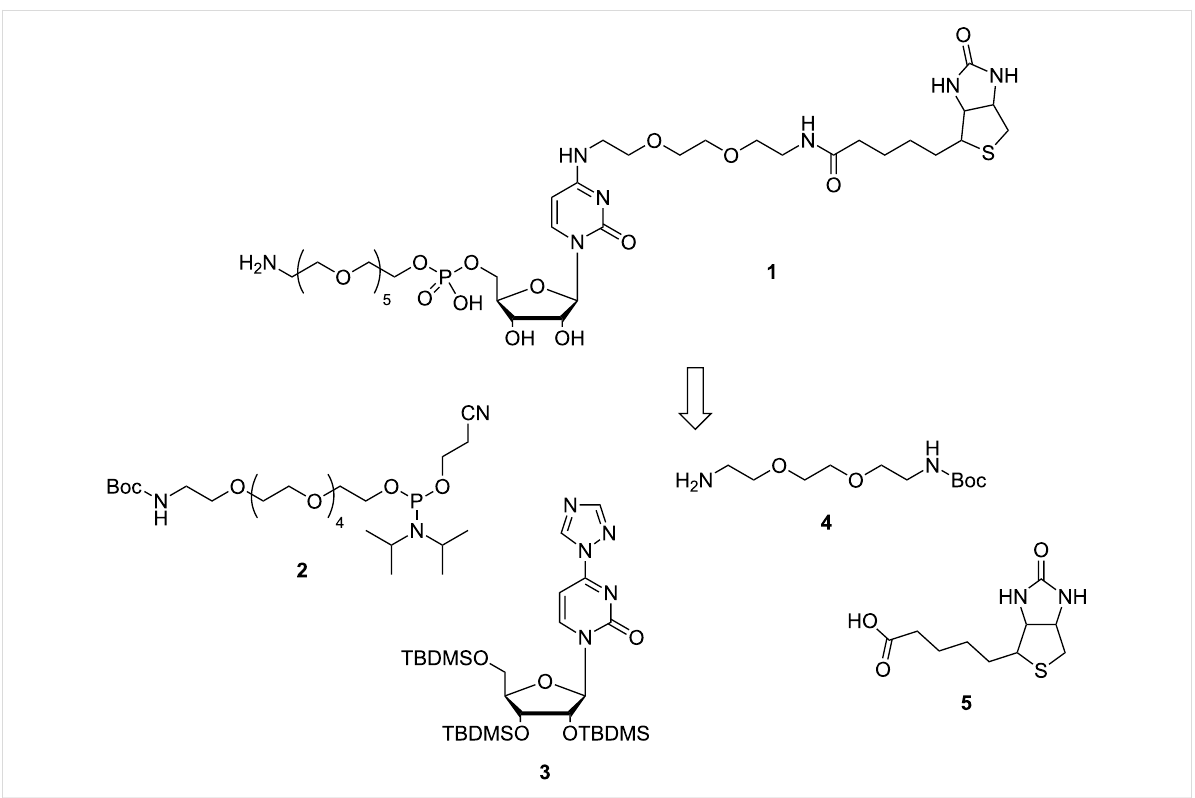
Figure 1: Retrosynthetic analysis of the bifunctional cytidine derivative 1 for functionalization of a periodate-oxidized RNA library.